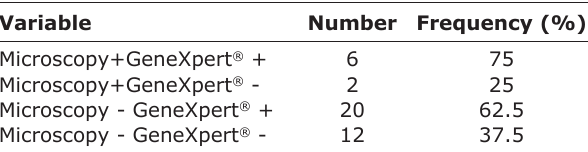
Table-2: Comparative analysis of microscopic and molecular test results.